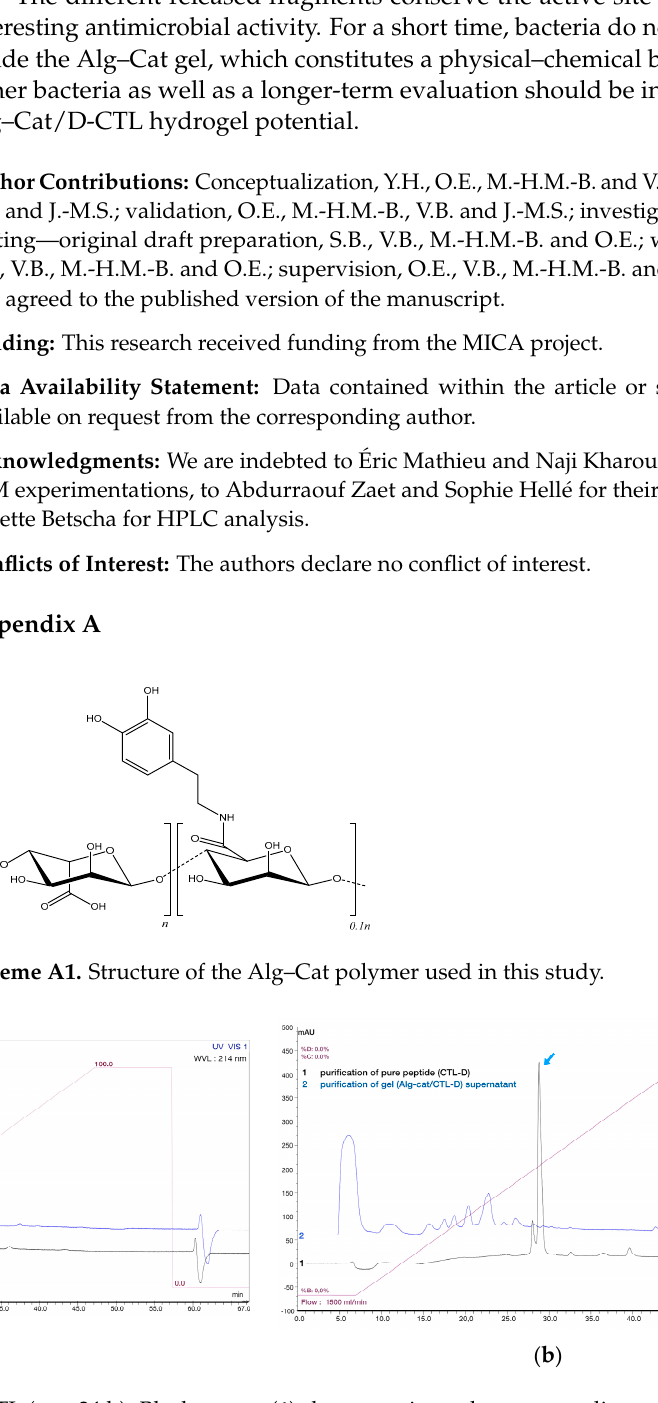
Figure 6. Alg–Cat 1% with/without antimicrobial agent and P. gingivalis (MEB view). ( a , b ) Gel presents a porous structure that could be layered by biofilm; ( c , d ) P. gingivalis colonize the surface and pores when an antibacterial agent is not present; ( e , f ) when charged with D-CTL, no bacteria were found at 24 h.